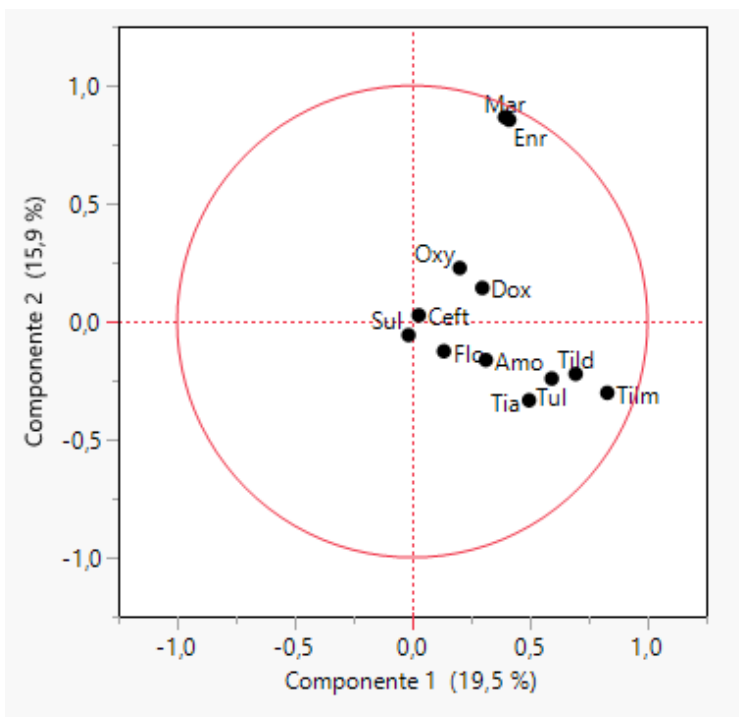
Figure 1. Biplot obtained through a principal component analysis of MIC values for twelve antimicrobials and 490 strains of Actinobacillus pleuropneumoniae (APP). The antimicrobials tested were amoxicillin (Amo), ceftiofur (Ceft), doxycycline (Dox), enrofloxacin (Enr), florfenicol (flo), marbofloxacin (Mar), oxytetracycline (Oxy), sulfamethoxazole/trimethoprim (Sul), tiamulin (Tia), tildipirosin (Tild), tilmicosin (Tilm) and tulathromycin (Tul).